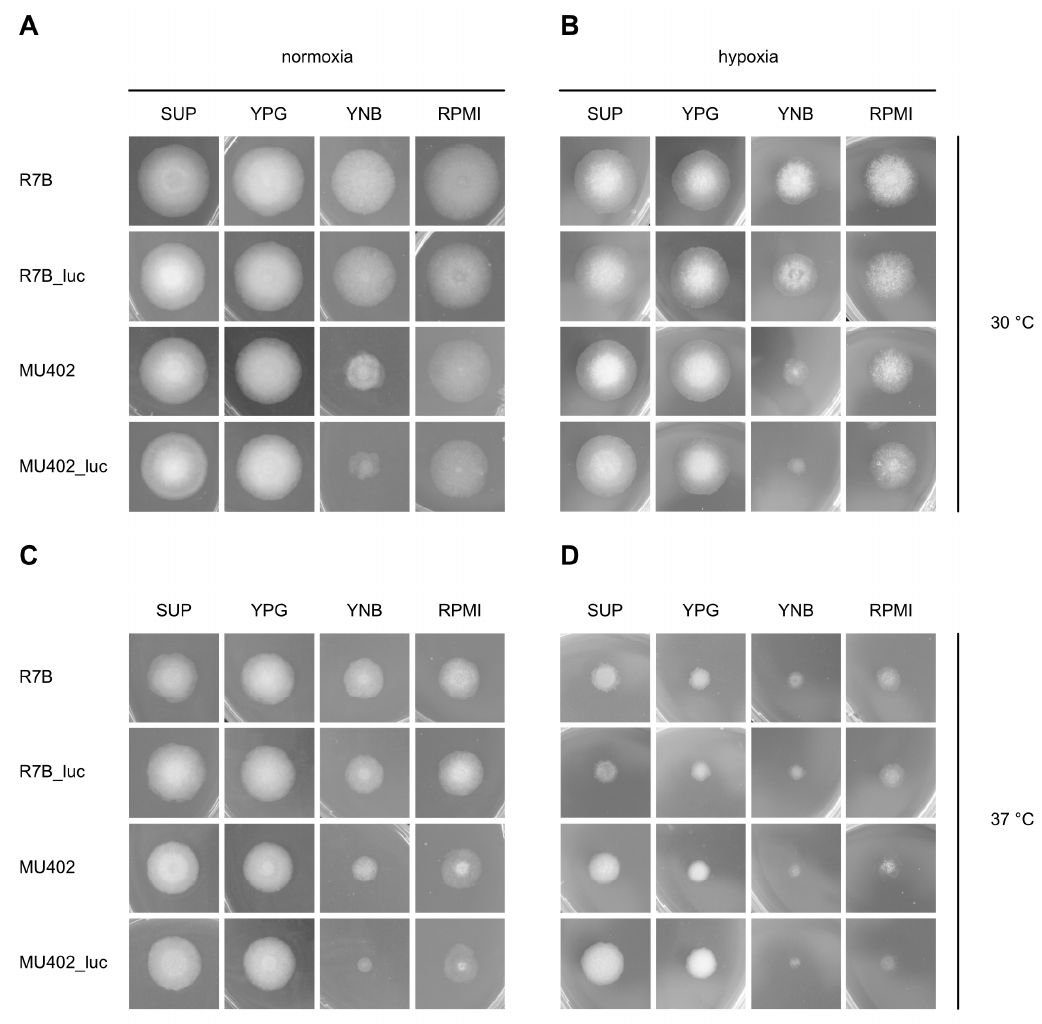
Figure 1. Growth phenotypes of recipient and luciferase-expressing strains grown for 24 h on different media at 30 ◦ C (panels ( A , B )), 37 ◦ C (panels ( C , D )) under normoxic (panels ( A , C )) and hypoxic conditions (panels ( B , D )). Hypoxia was induced by reducing the oxygen concentration in the